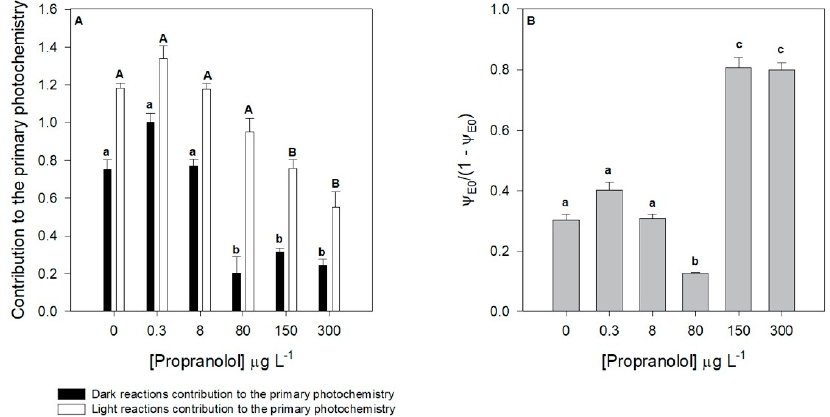
Figure 4. Energy required to close all RCs (S M , A ), RC turnover rate (N, B ) and the size of the quinone pool (area, C ) in Phaeodactylum tricornutum cultures exposed to different propranolol concentrations (average ± standard error, n = 3, letters denote differences at p < 0.05). Biology 2020 , 9 , x